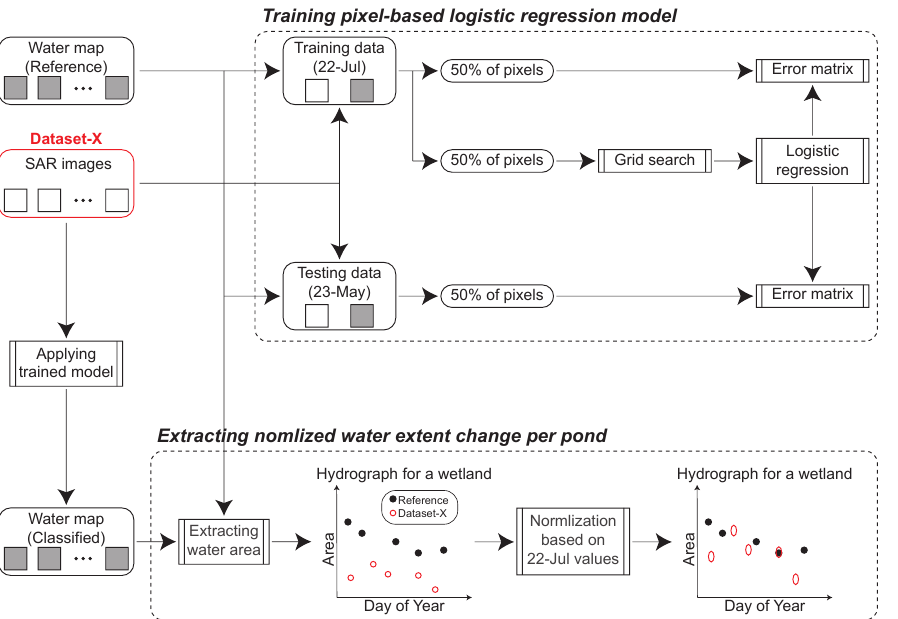
Figure 13. Schematic overview of the experimental analyses. We denote an arbitrary dataset as